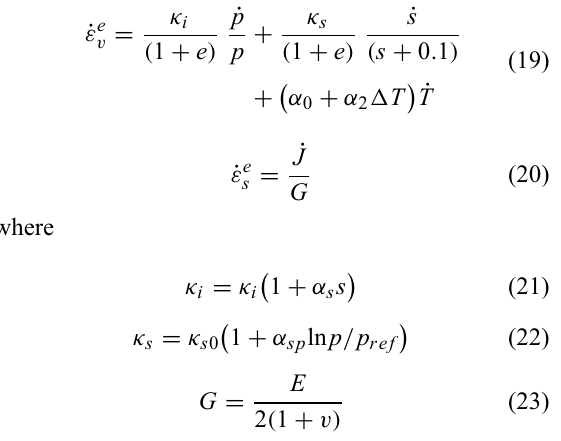
Model parameters related to the mechanical prob- lem (defining the Barcelona Basic